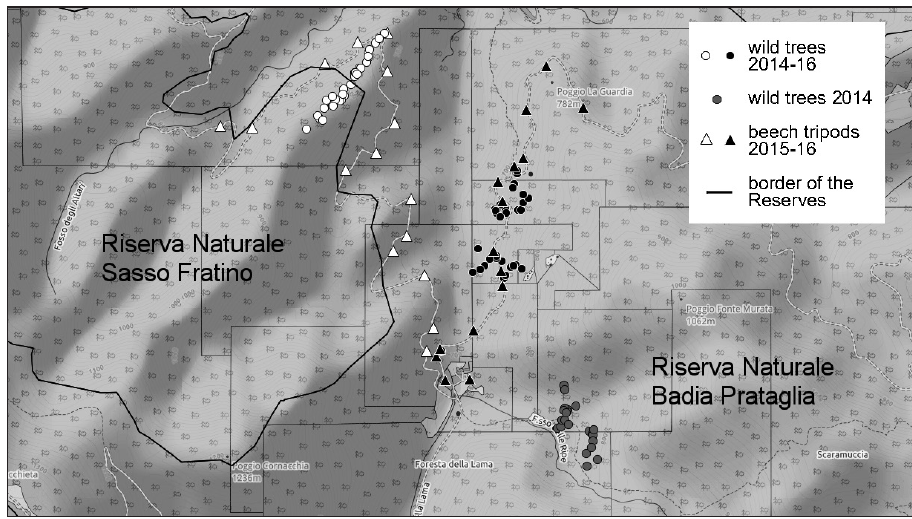
Figure 6. Map of the study area Foreste Casentinesi. White symbols refer to the sub-area “Poggio Ghiac- cione”, black symbols refer to the sub-area “Strada per Badia”, grey symbols refer to the sub-area “La